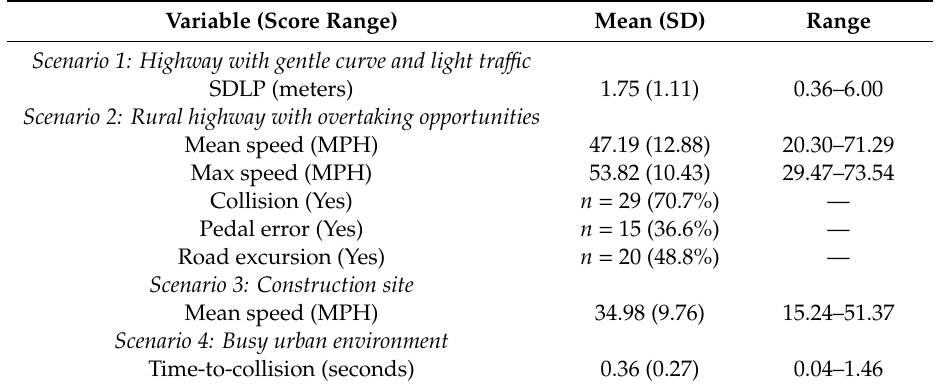
Table 5. Study sample performance in the traditional research-based driving